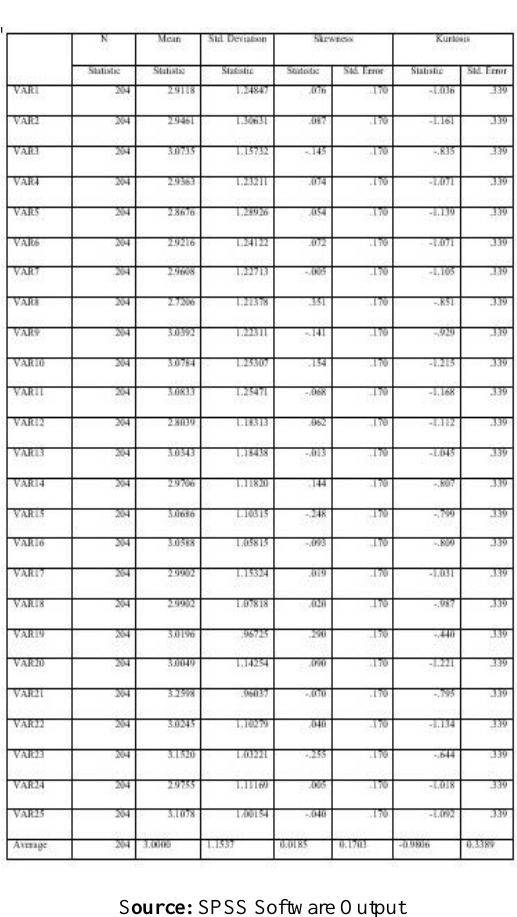
Table 3: Skewness and Kurtosis